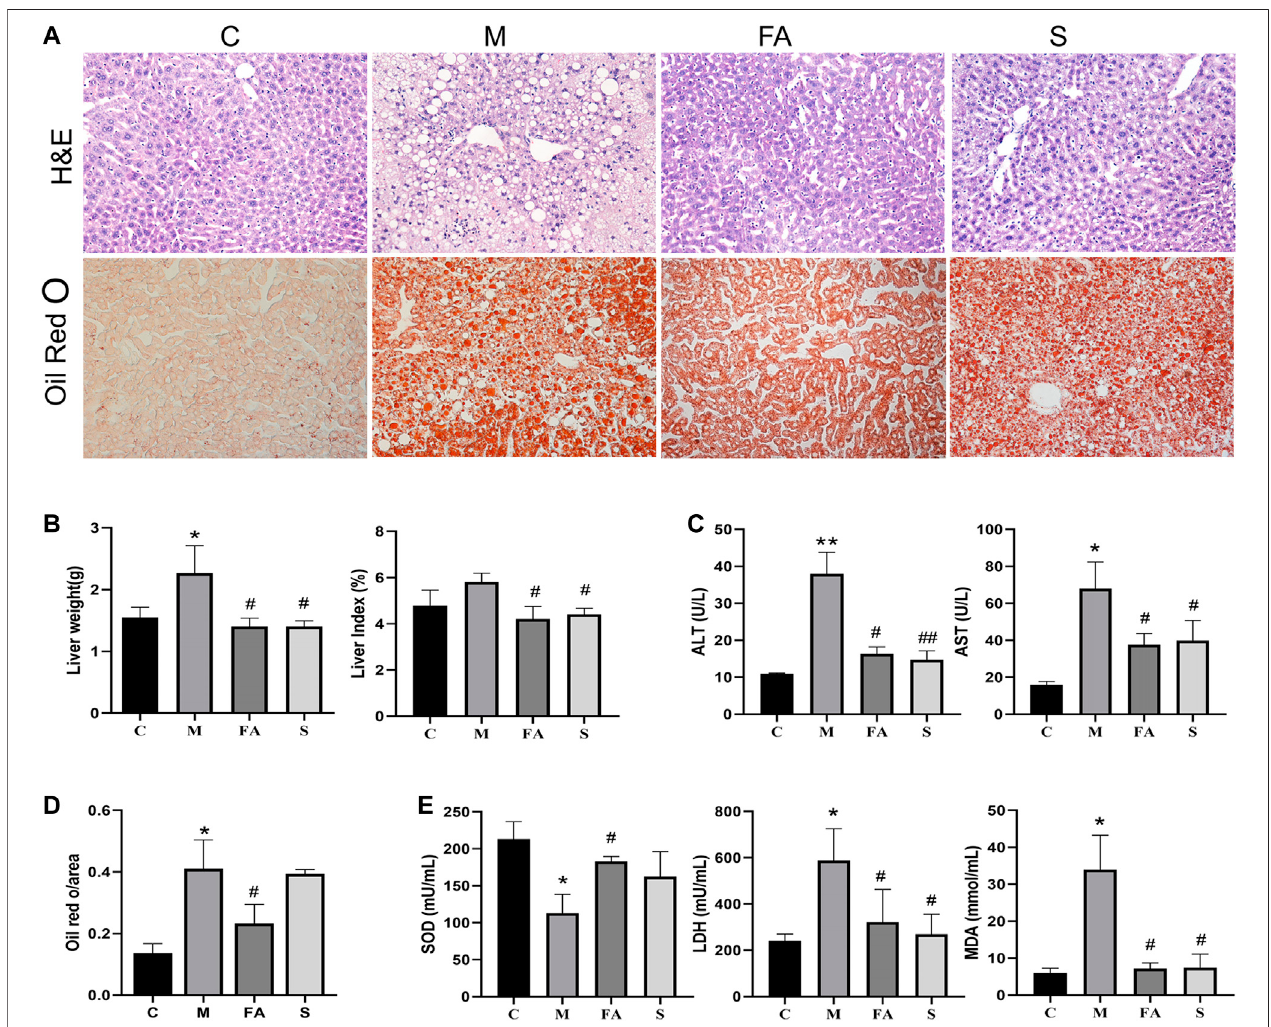
FIGURE3| FA improved fatty liverinjury in ApoE − / − miceinducedby HFD. (A) H&Estaining ofliverparaf fi n sections, ORO stainingofliver sections (200 × ). (B) Liver weight,livercoef fi centinvariousgroups( n (cid:2) 4). (C) ThelevelofALTandASTinserum( n (cid:2) 4). (D) QuantitativeanalysisofOilredOinliver( n (cid:2) 3). (E) Thechangeofserum SOD, LDH, MDA in various groups ( n (cid:2) 4). * p < 0.05, ** p < 0.01; as compared to the control group. # p < 0.05, ## p < 0.01; as compared to the model